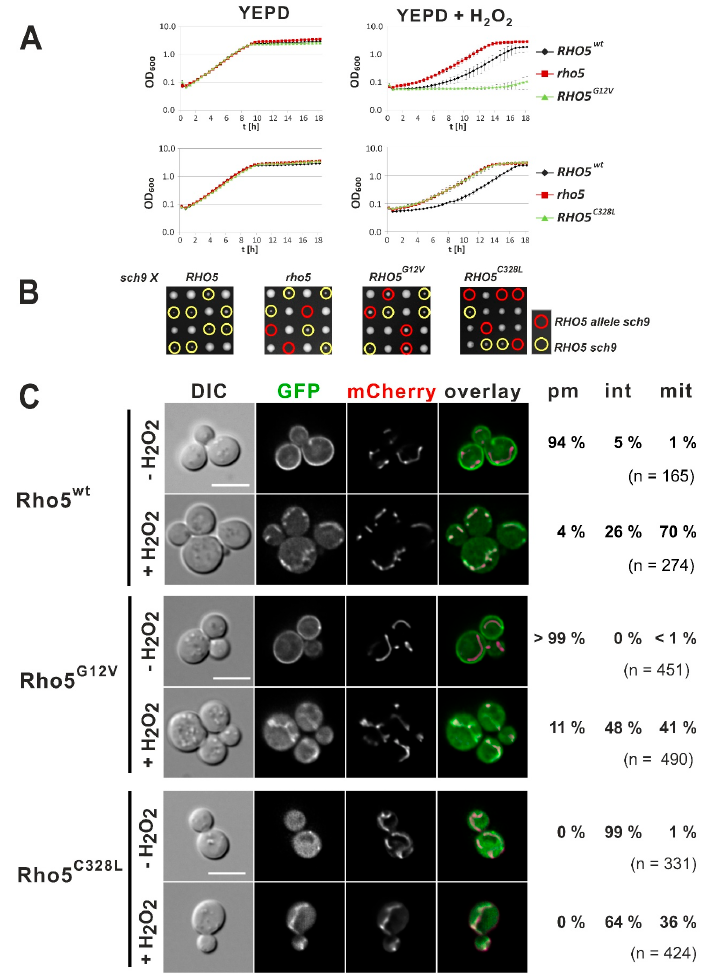
Figure 2. Growth and response to oxidative stress of Rho5 G12V and Rho5 C328L mutants. ( A ) Comparative growth behavior of strains with the indicated RHO5 alleles. Growth curves were recorded in rich medium in the absence or presence of hydrogen peroxide as indicated. ( B ) Tetrad analyses of crosses from strains carrying the indicated RHO5 allele to a sch9 deletion strain performed on rich medium (YEPD). Note that sch9 deletions grow more slowly and produce much smaller colonies than wild-type or rho5 deletions, and that rho5 sch9 double deletions are not viable. Yellow circles indicate tetrads carrying a wild-type RHO5 allele and a sch9 deletion, red circles mark the double mutants of sch9 with the RHO5 alleles indicated above each image. Parental strains crossed to HOD348-4D ( sch9 ) from left to right were: HD56-RHwt ( RHO5 ), HOD295-7D ( rho5 ), HD56-R8 ( RHO5 G12V ), and HD56-RH C328L ( RHO5 C328L ). See Table 1 for genotypes. ( C ) Life-cell fluorescence microscopy of a rho5 deletion strain with a genomic IDP1-mCherry fusion as a mitochondrial marker (HCSO76-1A) expressing N-terminal GFP fusions of the Rho5 variants as indicated, each from a CEN / ARS vector. Cells were grown on synthetic media selecting for maintenance of the plasmid and either examined without further treatment (upper panels), or after addition of 4.4 mM hydrogen peroxide for less than 15 min (lower panels). The percentage of cells displaying association of the GFP signal with the plasma membrane (pm), being cytosolic or associated with internal structures (int), and those showing colocalization with the mitochondrial marker (mit) were determined for the total number of cells counted in each sample ( n ).